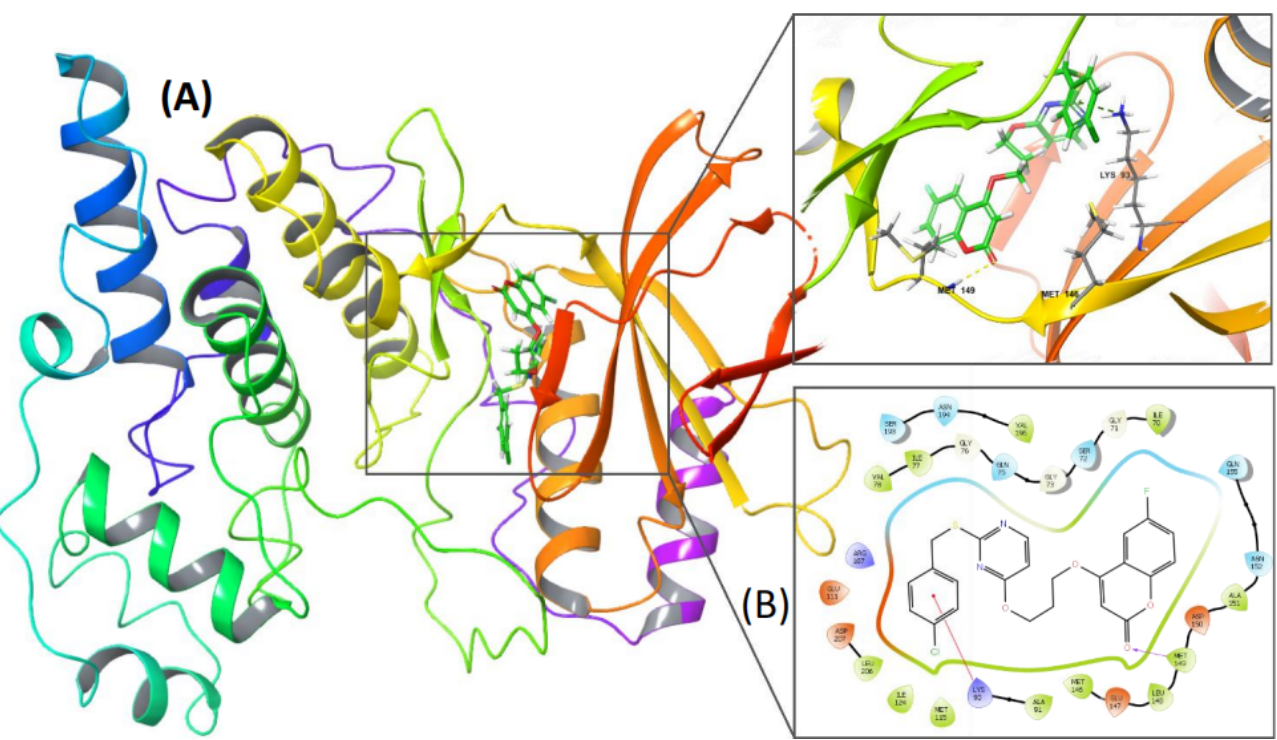
Figure 7. Illustrated representation of JNK3 and PC-12 complex. ( A ) Three-dimensional interaction of PC-12 with amino acid residues at the active site of the receptor. ( B ) Two-dimensional interaction diagram of JNK3 and PC-12.